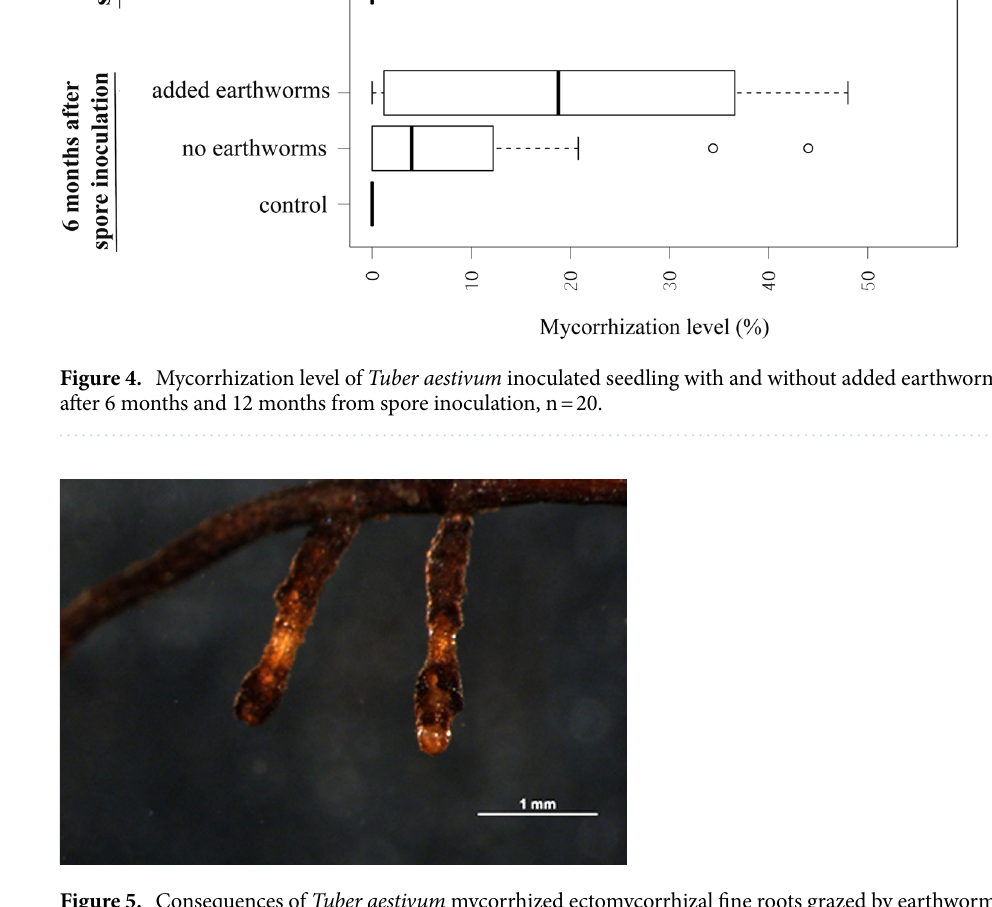
Figure 5. Consequences of Tuber aestivum mycorrhized ectomycorrhizal fine roots grazed by earthworms. Ectomycorrhizal fine roots which were partially or completely grazed were regarded as old and senescent ectomycorrhizal root tips and were counted as non-mycorrhizal root